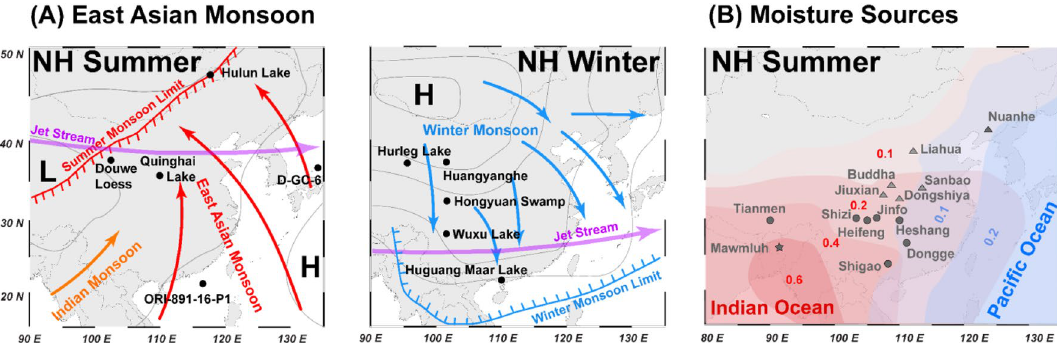
Figure 1. East Asian summer (EASM) and winter monsoon (EAWM) purview and sites used for this study. ( A ) Atmospheric conditions during North Hemisphere summer (EASM). Northward propagating warm and moisture charged air masses are indicated by red arrows (left panel); Atmospheric conditions during North Hemisphere winter (EAWM). Southward trending cold air outbreaks are highlighted by blue arrows (right panel); ( B ) Moisture sources of East Asia during North Hemisphere summer (EASM) 45 . Numbers constitute relative contribution of the Indian Ocean (red) or Pacific Ocean (blue) moisture source to total amount of precipitation over East Asia. Sites used for the EASM and EAWM stack are marked by black dots in ( A ) and ( B ), respectively (Tables S1, S2). Purple arrow indicates position of the Jetstream. Location of the speleothem reference sites for the northern and southern Chinese speleothem stacks are marked by grey triangles and dots, respectively. Mawmluh speleothem cave site is marked with a grey